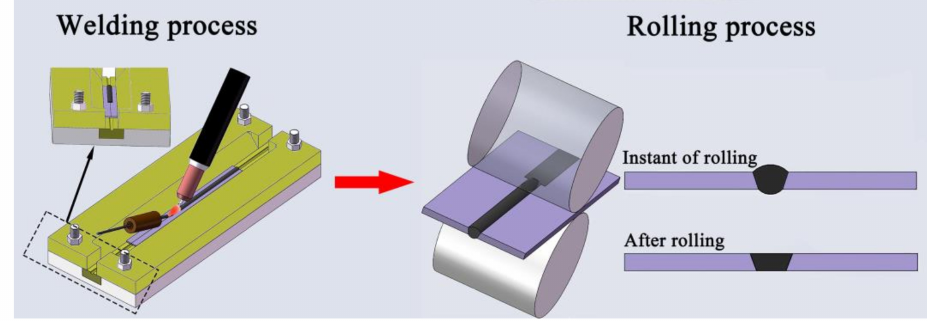
Figure 24. Schematic diagram of post-weld partial